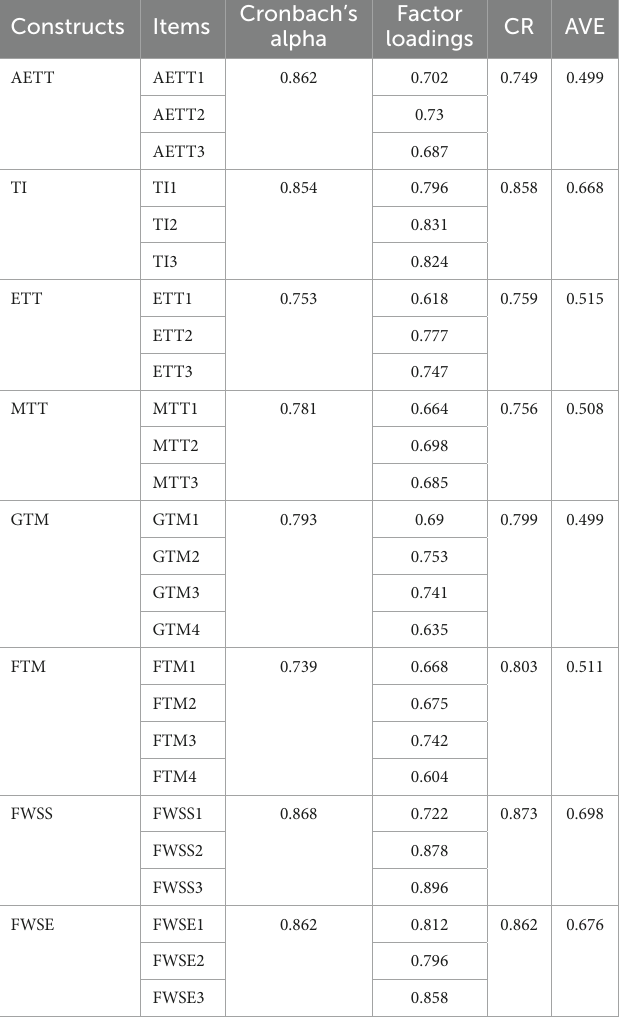
TABLE 7 Reliability and convergent validity results. Constructs